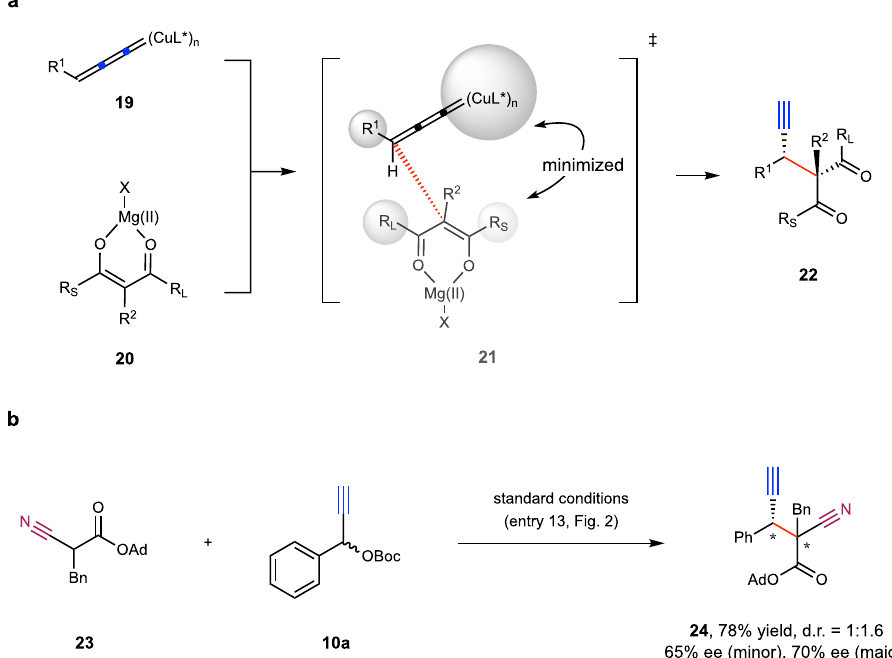
Fig. 6 Mechanistic studies. a Proposed stereochemical model. b Reaction of substrate 23 . The ee value was determined by HPLC analysis. The d.r. value was determined by 1 H NMR analysis of the crude reaction mixture. See SI for experimental